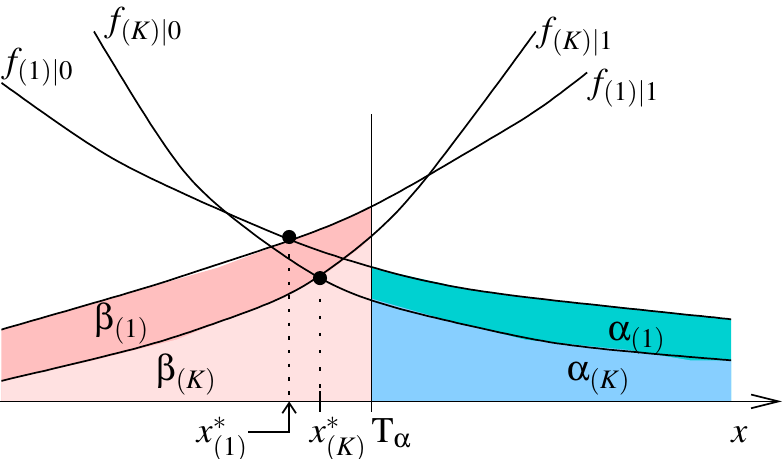
Figure 1. The sampling distributions without (1) and with sample averaging (K) for the signal classes C = 0 and C = 1, respectively. The filled areas are the probabilities of Type I error ( α ) and Type II error ( β ). The symbol x ∗ indicates an equal likelihood, and T α is the decision threshold between the two